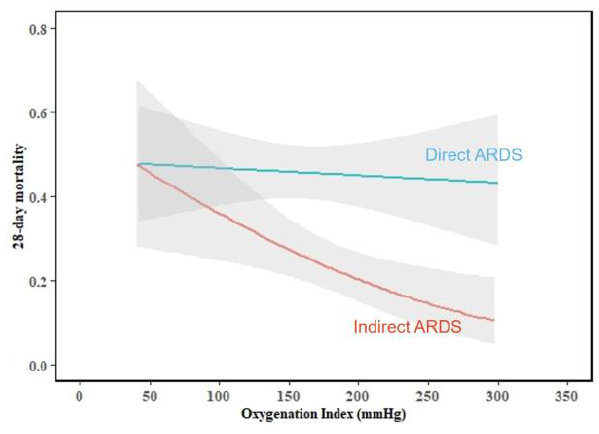
Figure 4. The interaction between oxygenation index and ARDS type (test for interaction, p <